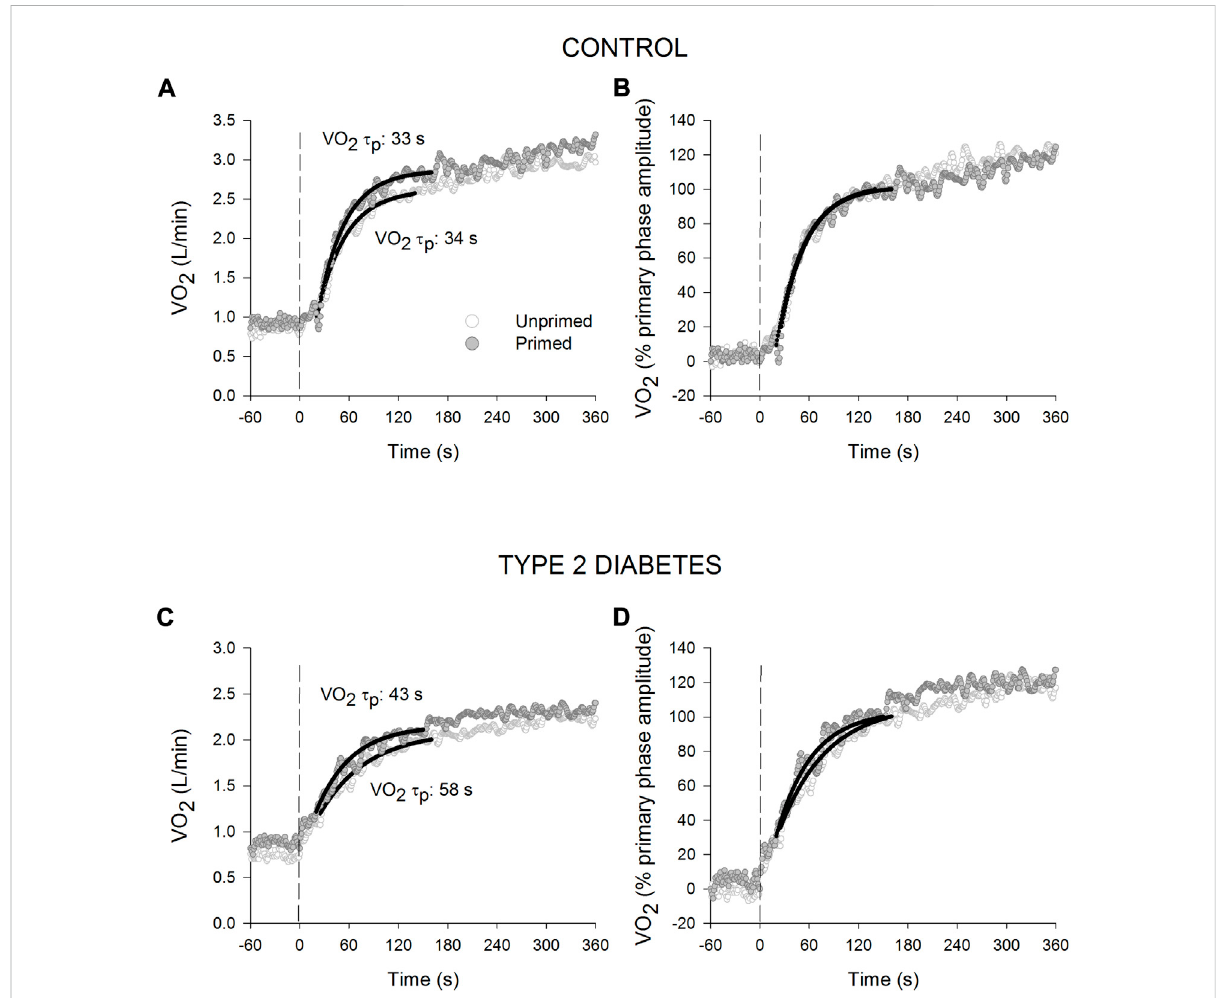
FIGURE 2 · O 2 )responsesforarepresentativehealthycontrol( (A) :absolutevalues; (B) :normalisedtothe%primaryphaseV Oxygenuptake(V and an individual with type 2 diabetes ( (C) : absolute values; (D) : normalised to the % primary phase V transitions without priming exercise (open circles) and with priming exercise (solid circles). The vertical line illustrates the abrupt transition to the higher work rate. The continuous lines of best fi t illustrate the primary phase of the oxygen uptake (V · response of the primary phase of the V O 2 response in the unprimed compared with the primed bout in